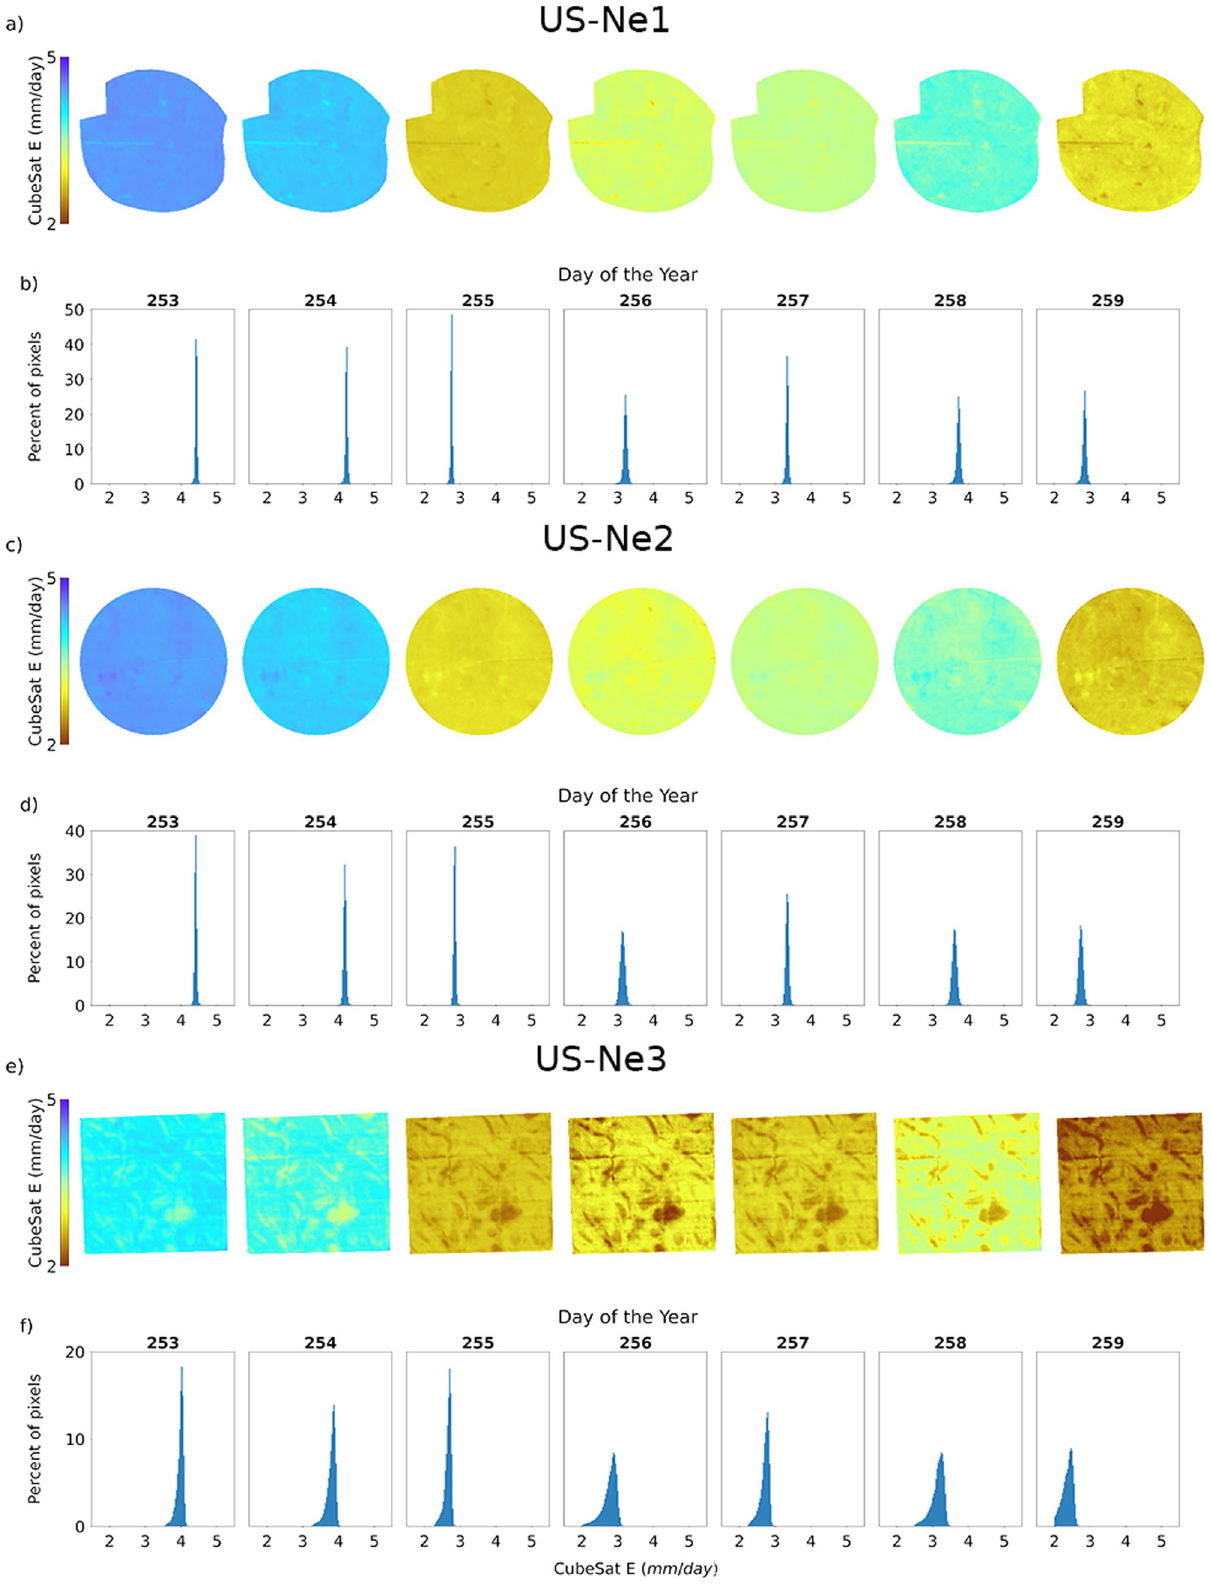
Figure 2. Spatial maps and related histograms of daily CubeSat-based E for the period September 9–15, 2019: approximately two months prior to harvest. Panels ( a , b ) correspond to US-Ne1, ( c , d ) to US-Ne2, and ( e , f ) to